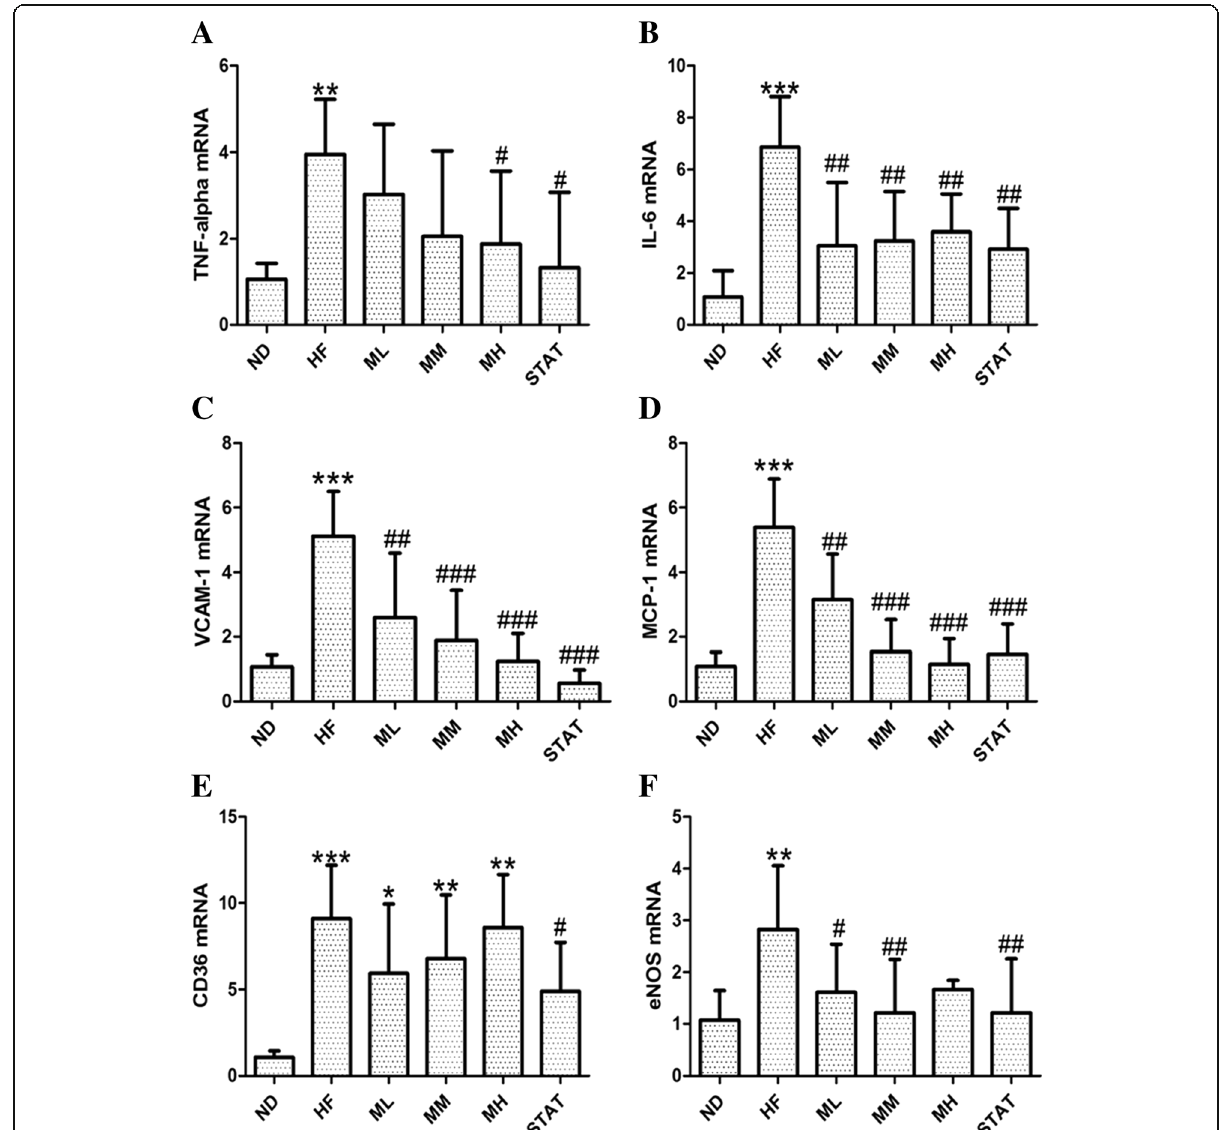
Fig. 4 TNF- α , IL-6, VCAM-1, MCP-1, CD36 and eNOS mRNA levels from cardiac tissues of each groupby Real-time PCR detection. The expressions of TNF- α , IL-6, VCAM-1, MCP-1, CD36 and eNOS mRNA in HF group were significantly higher than those in the ND group. The expressions of IL-6, VCAM-1, MCP-1, and eNOS mRNA in Maoberrytreated groups were significantly lower than those in the HF group. Each bar represents the relative mean±SD, n=12 each. * p <0.05, ** p <0.01 and *** p <0.01 represent significant differences when compared with the ND group. # p <0.05, ## p <0.01 and ## #p <0.001 represent significant differences when compared with the HF group. ND: a standard diet, HF: a high fat diet, ML, MM, MH: a high fat diet with Maoberry extract 0.38 or 0.76 or 1.52g/kg, respectively, STAT: a high fat diet with simvastatin